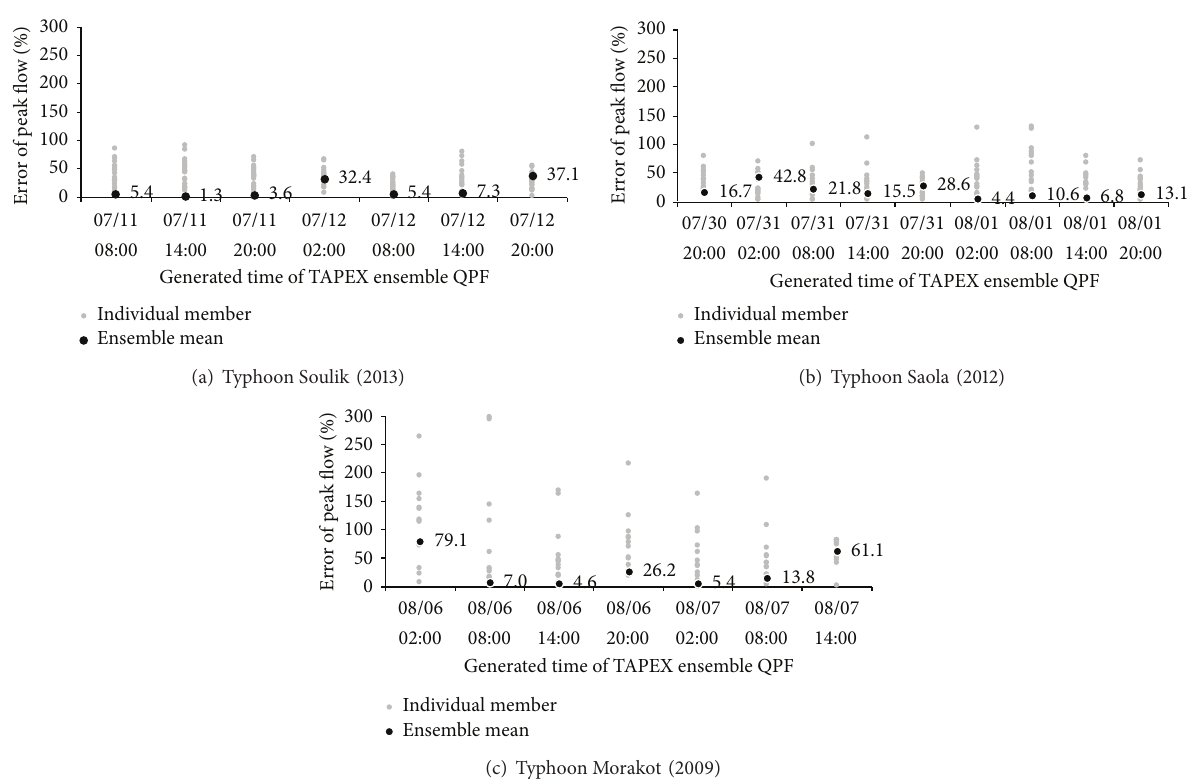
ensemble-mean forecast were 13.2, 17.8, and 28.2 percent